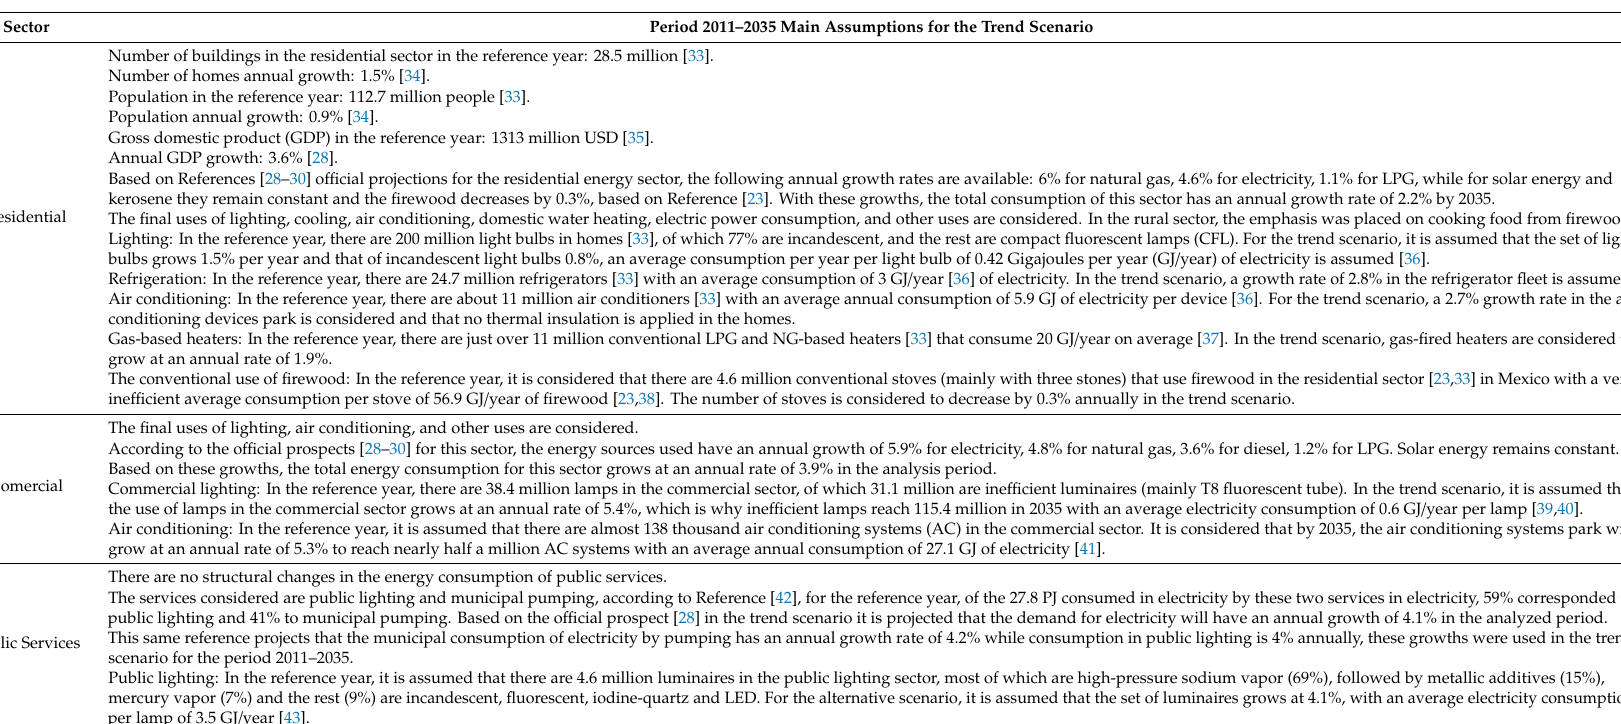
Table 1. Main assumptions by sector for the trend